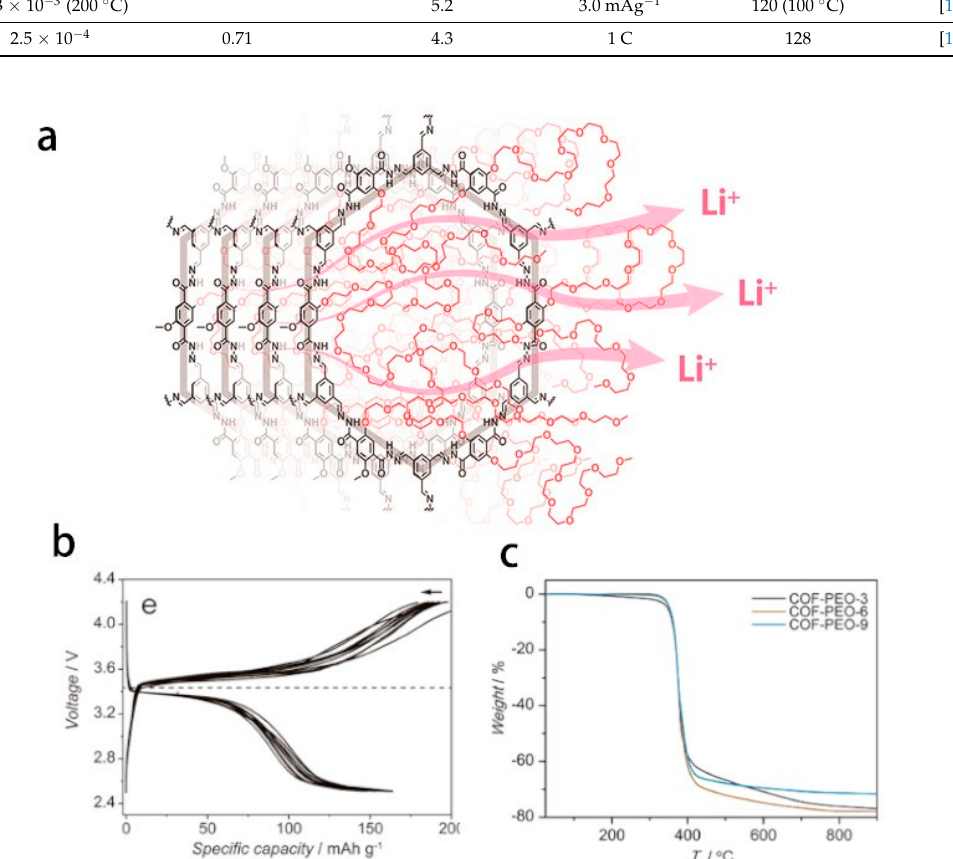
Figure 3. ( a ) Schematic diagram of fast directional transport of lithium ions in 2D COF structures by solvated Li + − polyethylene oxide (PEO). ( b ) Charge − discharge curves of an all − solid − state battery of LiFePO 4 /COF − PEO − 9-Li/Li cell at a current intensity of 3.0 mAg − 1 and cutoff voltage of 2.5 to 4.2 V at 100 °C. ( c ) TGA profiles measured at 10 °C min − 1 . Adapted with permission from ref.